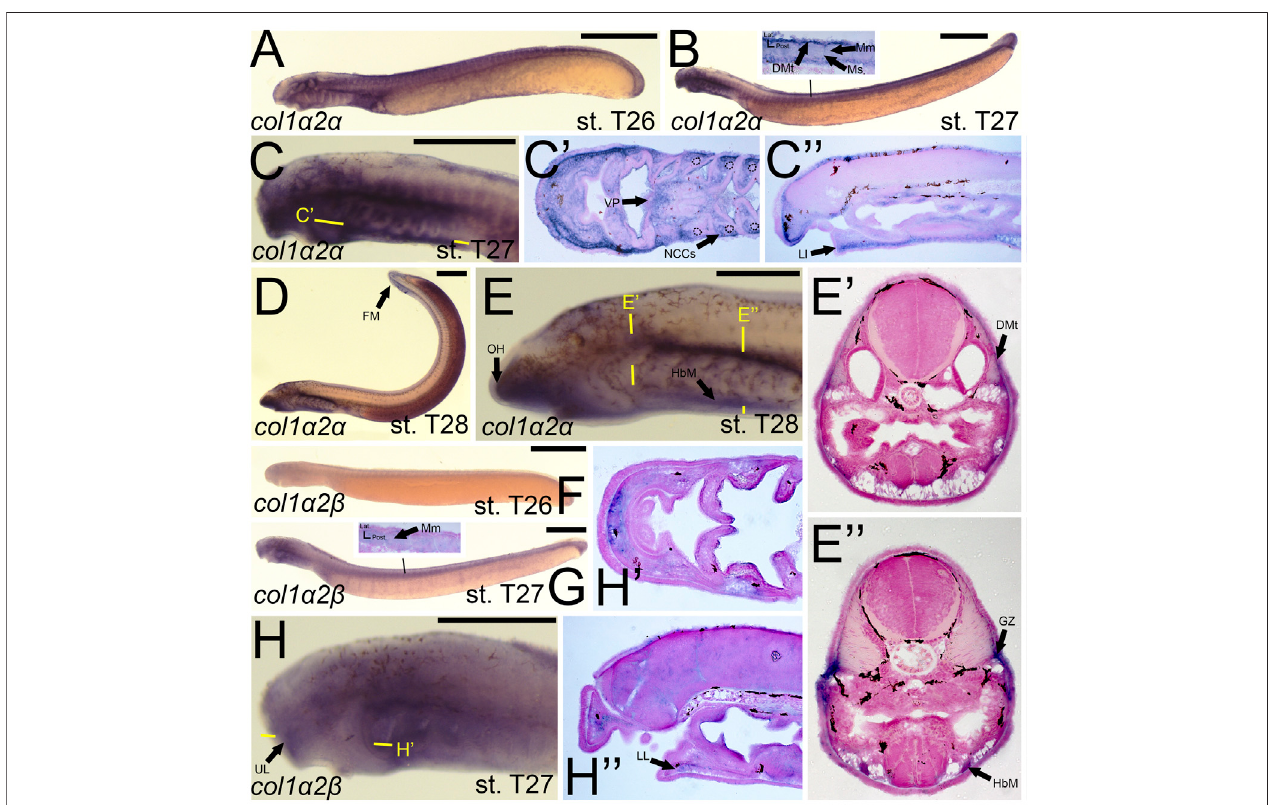
FIGURE 5 | Expression of colA1/col1a2 α and colA2/col1a2 β in larval lamprey. All scale bars are approximately 500 μ m. (A) col1a2 α expression was in the cranial ganglia and throughout the head mesenchyme. (B,C) col1a2 α expression was in the mesenchyme of the fi n fold, lower lip, and ventral pharynx, the non-skeletogenic neural crest cells in the pharynx, the myosepta, myomeres, and the dermomyotome. Dotted circles indicate presumptive branchial arch skeleton. (D,E) col1a2 α expression was in the mesenchyme of the fi n fold, lower lip, and oral hood, as well as the hypobranchial musculature, the myomere growth zone, and the dermomyotome. (F) col1a2 β expression was minimal at stage T26. (G,H) col1a2 β expression was in the mesenchyme of the upper and lower lip, and was weak albeit present in the myomeres. Keywords: DMt: dermomyotome; FM: fi n mesenchyme; GZ: growth zone; HbM: hypobranchial muscle; LL: lower lip; Mm: myomeres; Ms: myosepta; NCCs: neural crest cells; UL: upper lip; VP: ventral pharynx.